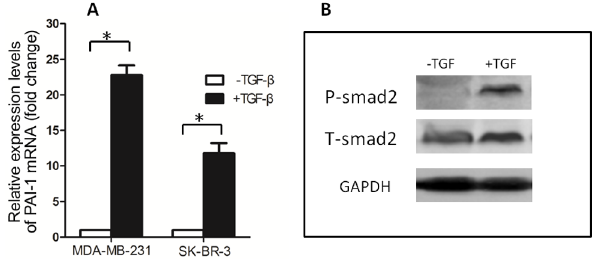
Figure 3. The sensitivity of breast cancer cell lines to TGF- b . (A) Induction of PAI-1 mRNA by TGF- b in breast cancer cell lines. MDA-MB- 231 and SK-BR-3 cells were treated for 2 h with or without TGF- b (100 pM) before isolation of total RNA with Trizol. PAI-1 mRNA levels were determined with RT-Quantitative PCR. Data are means 6 SD of at least three independent experiments in each condition. * P , 0.05. (B) TGF- b induced phosphorylation of Smad2 in SK-BR-3 cells. SK-BR-3 cells in complete medium was treated for 30 min with or without TGF- b (100pM) before being lysed with SDS sample buffer. The level of Phospho-Smad2 was analyzed by